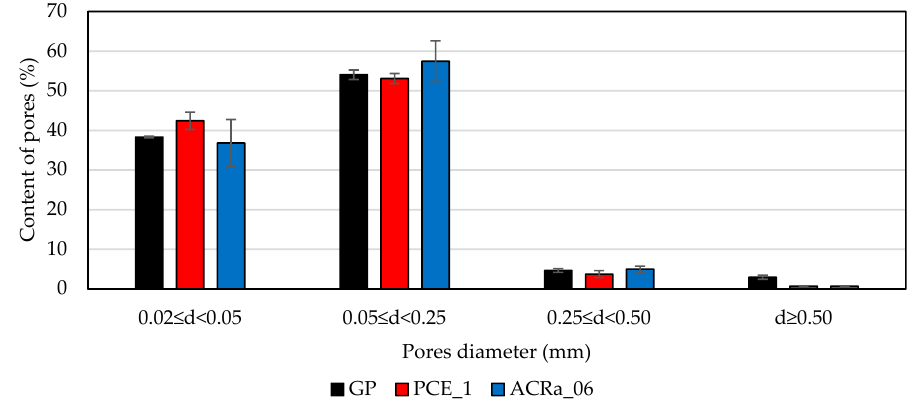
Figure 6. Pore distribution obtained via image analysis of two sections of hardened mortar (investigated area = 145 mm 2 ).